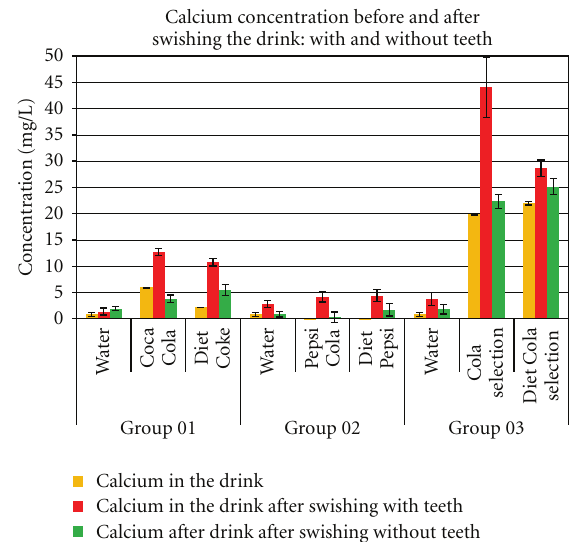
Figure 3: Calcium measures of swishes. Initial swishes were done for all groups with the same water (Aquafina) as